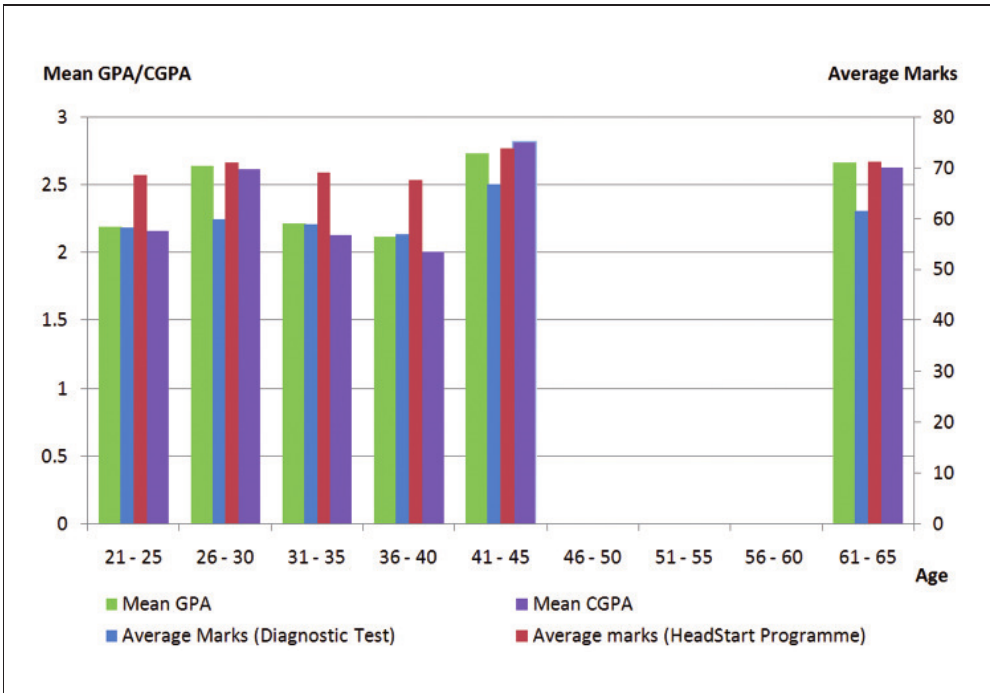
Figure 5 Performance of Group B students who successfully completed the HeadStart programme before progressing into the undergraduate programmes ( p<0.01